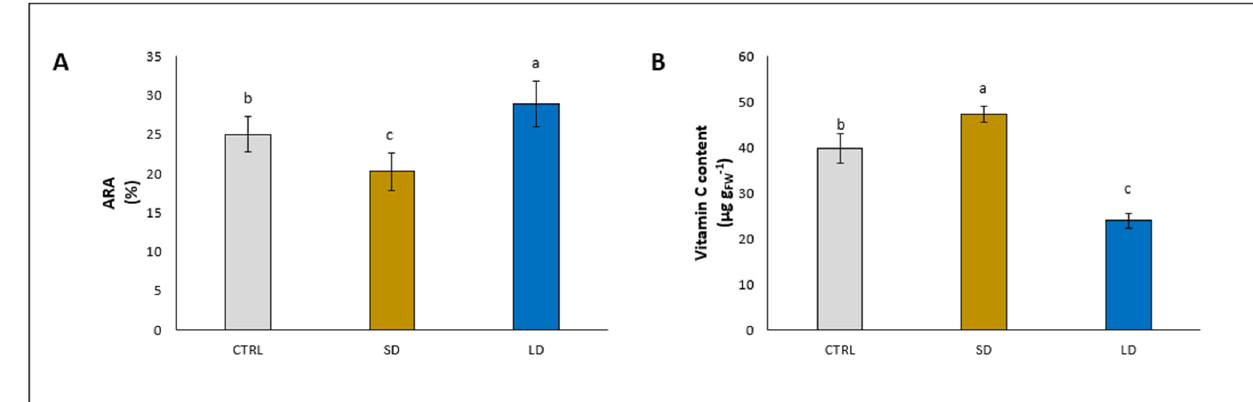
Figure 3. Antiradical activity ( ARA ) ( A ) and vitamin C content ( B ) in leaves of lettuce plants grown for 5 weeks without (CTRL) and with the application of digestate, either solid (SD) or liquid (LD). Parameters are expressed as mean ± standard error. Different letters indicate statistically significant differences ( p < 0.05).